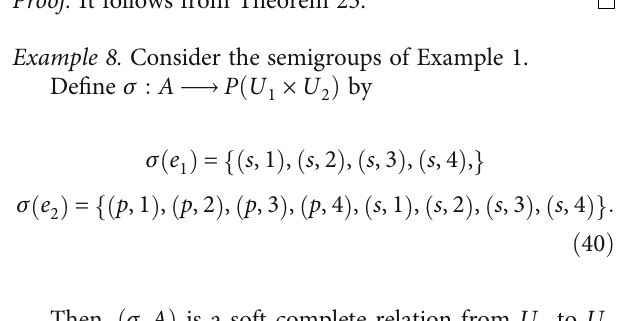
Table 29: Upper approximation of B .